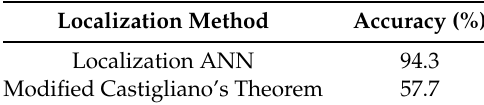
Table 4. Localization performance of the proposed ANN and modified Castigliano’s theorem, evaluated on test